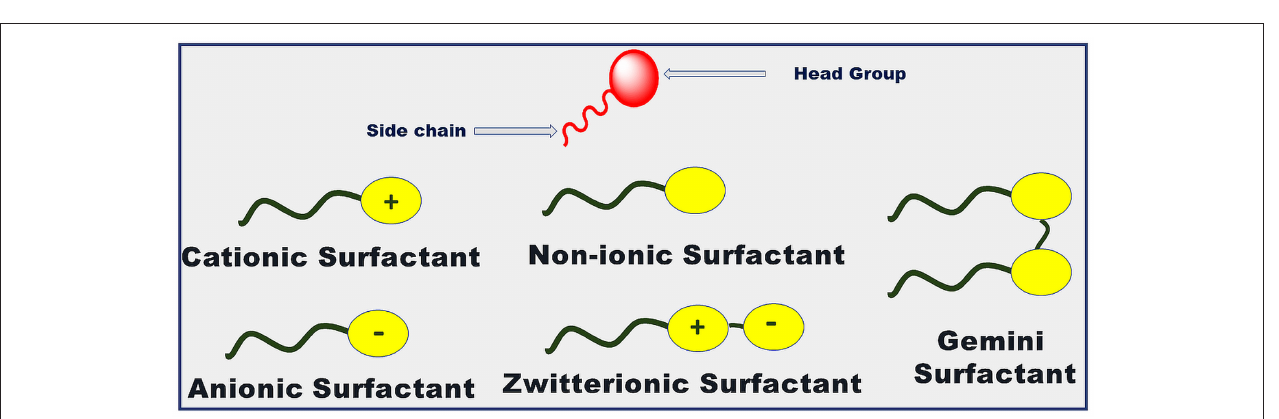
FIGURE 3 | Structure of surfactant with its various